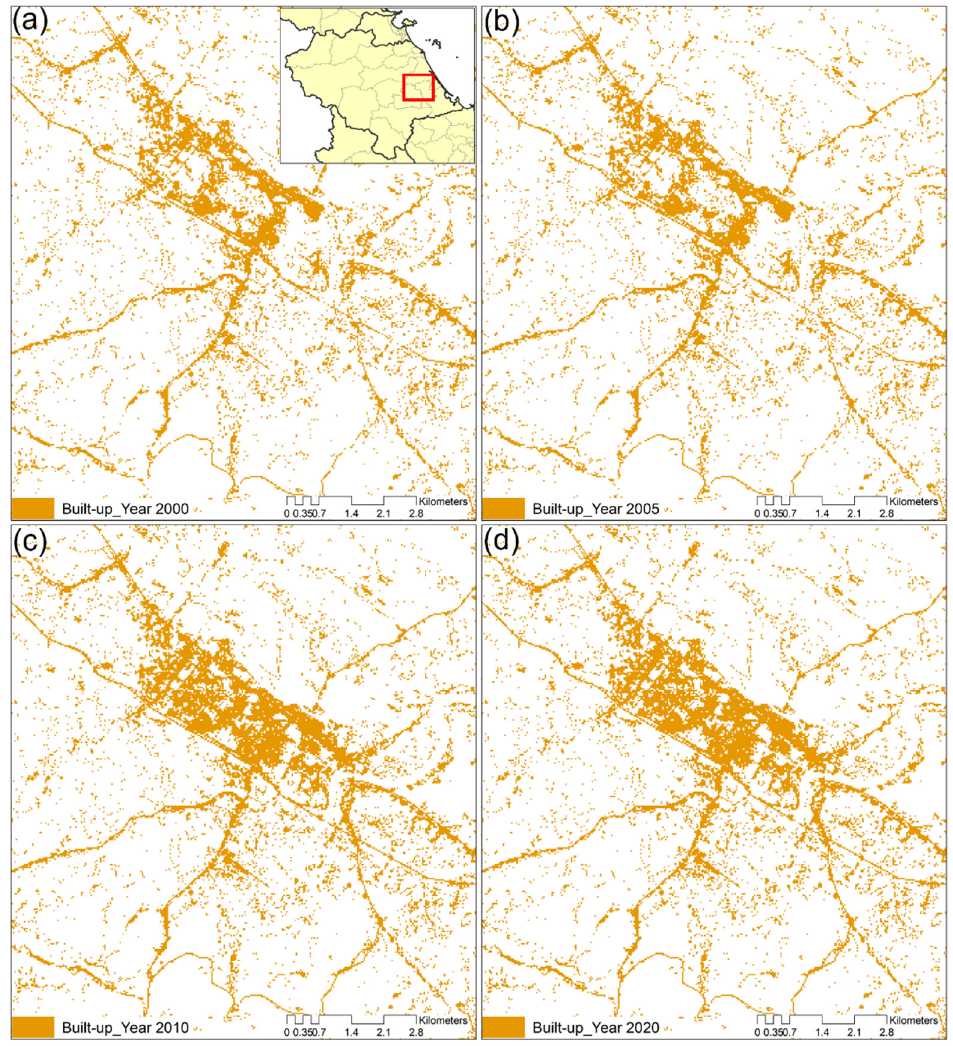
Figure 6. The distribution of built-up area in ( a ) 2000, ( b ) 2005, ( c ) 2010, and ( d ) 2020 in Quang Nam